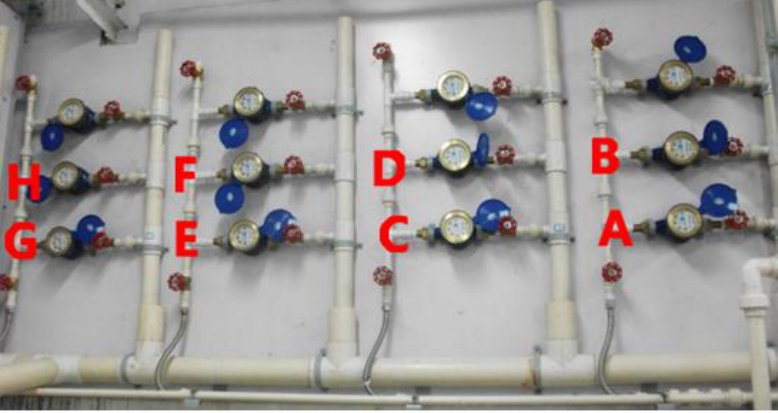
Fig. 3. Water Consuming Nodes and Leaking